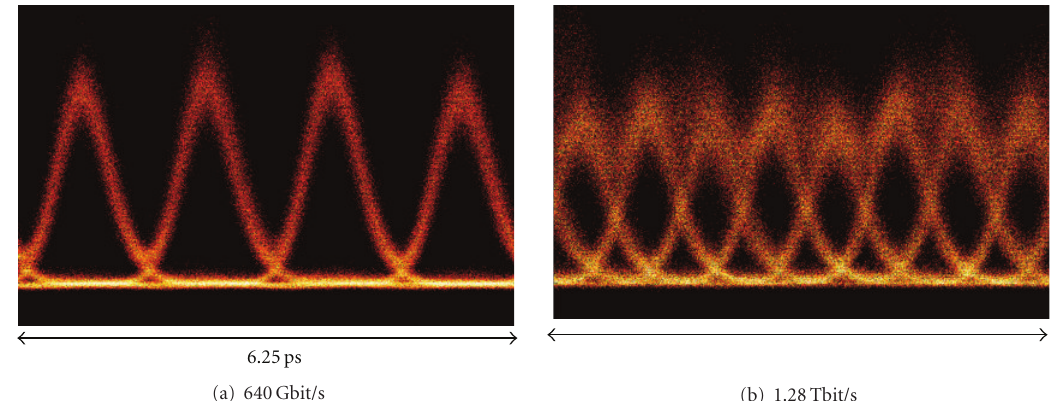
Figure 4: 1.28 Tbit/s data generation. Eye diagrams measured by an optical sampling oscilloscope with limited timing resolution to 1ps. (a) 640 Gbit/s eye diagram. (b) 1.28Tbit/s eye diagram. Note that the real pulses are only about 350fs wide.